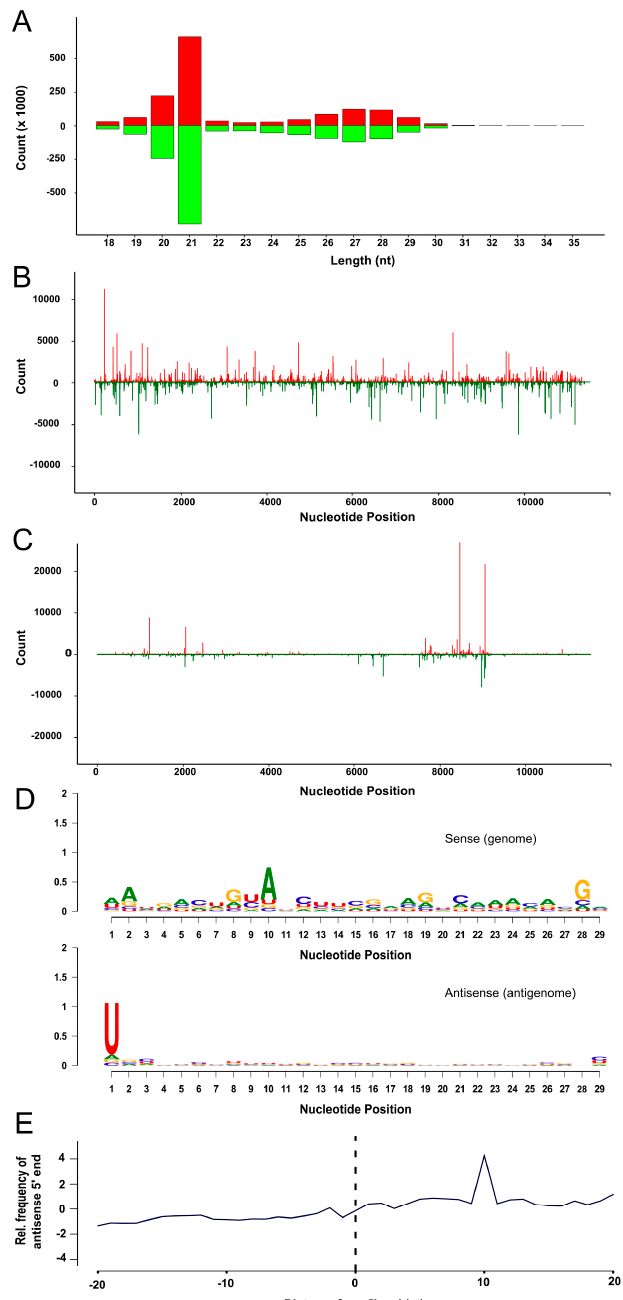
Figure 5. Characteristics of SFV-derived small RNAs in TRA-171 cells. RNA was isolated from TRA-171 cells 24 h p.i. with SFV4 at MOI 10 followed by small RNA sequencing. ( A ) The size distribution of small RNAs from SFV infected cells mapping to the SFV4 genome (red, positive numbers) or antigenome (green, negative numbers). The distribution of 21 nt ( B ) or 28 nt ( C ) small RNAs across the length of the SFV genome (red, positive numbers) or antigenome (green, negative numbers). The Y -axis shows the frequency of small RNAs mapping to the corresponding nucleotide location on the X -axis. ( D ) The conserved relative nucleotide frequency at each position of 29 nt long small RNAs mapping to the SFV4 genome or antigenome represented on a web logo diagram. The height of each nucleotide represents the degree of sequence conservation. The level of conservation is indicated by the Y -axis. ( E ) Frequency map showing the distance between the 5 1 ends of 25–29 nt small RNAs mapping to the opposite strand of the SFV4 reference sequence. Position 0 represents the first nucleotide. The results shown are representative of two independent